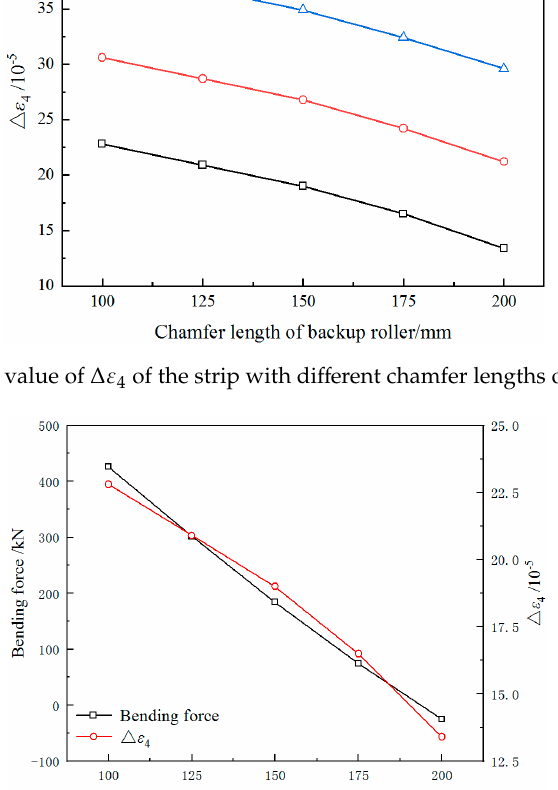
( b ) Figure 22. Compensation for the quarter buckle by the MVC: ( a ) schematic diagram; ( b ) contour of the sextic curve.